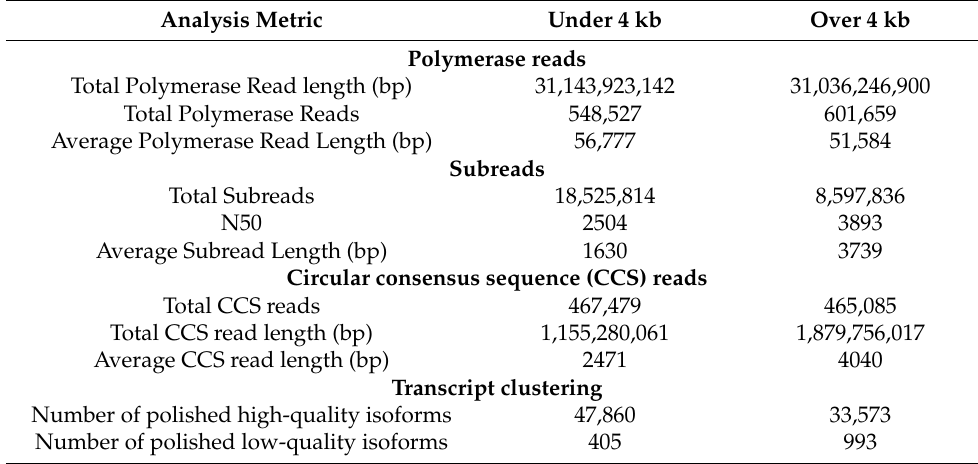
Table 1. PacBio summary of RNA-seq data from two RNA libraries of E. maculata .